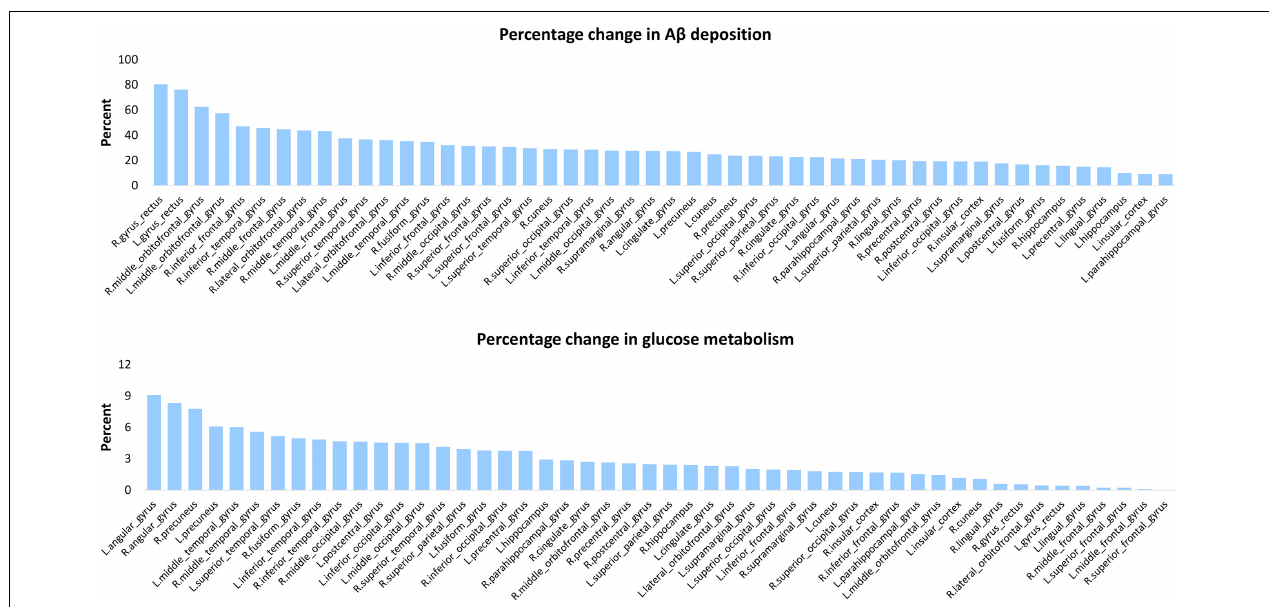
FIGURE 3 | Percentage change of A β deposition and glucose metabolism for each cortical area. This chart displays the percentage increase of A β deposition (top panel) percentage decrease and of glucose metabolism (bottom panel) of AD vs. controls in 50 cortical